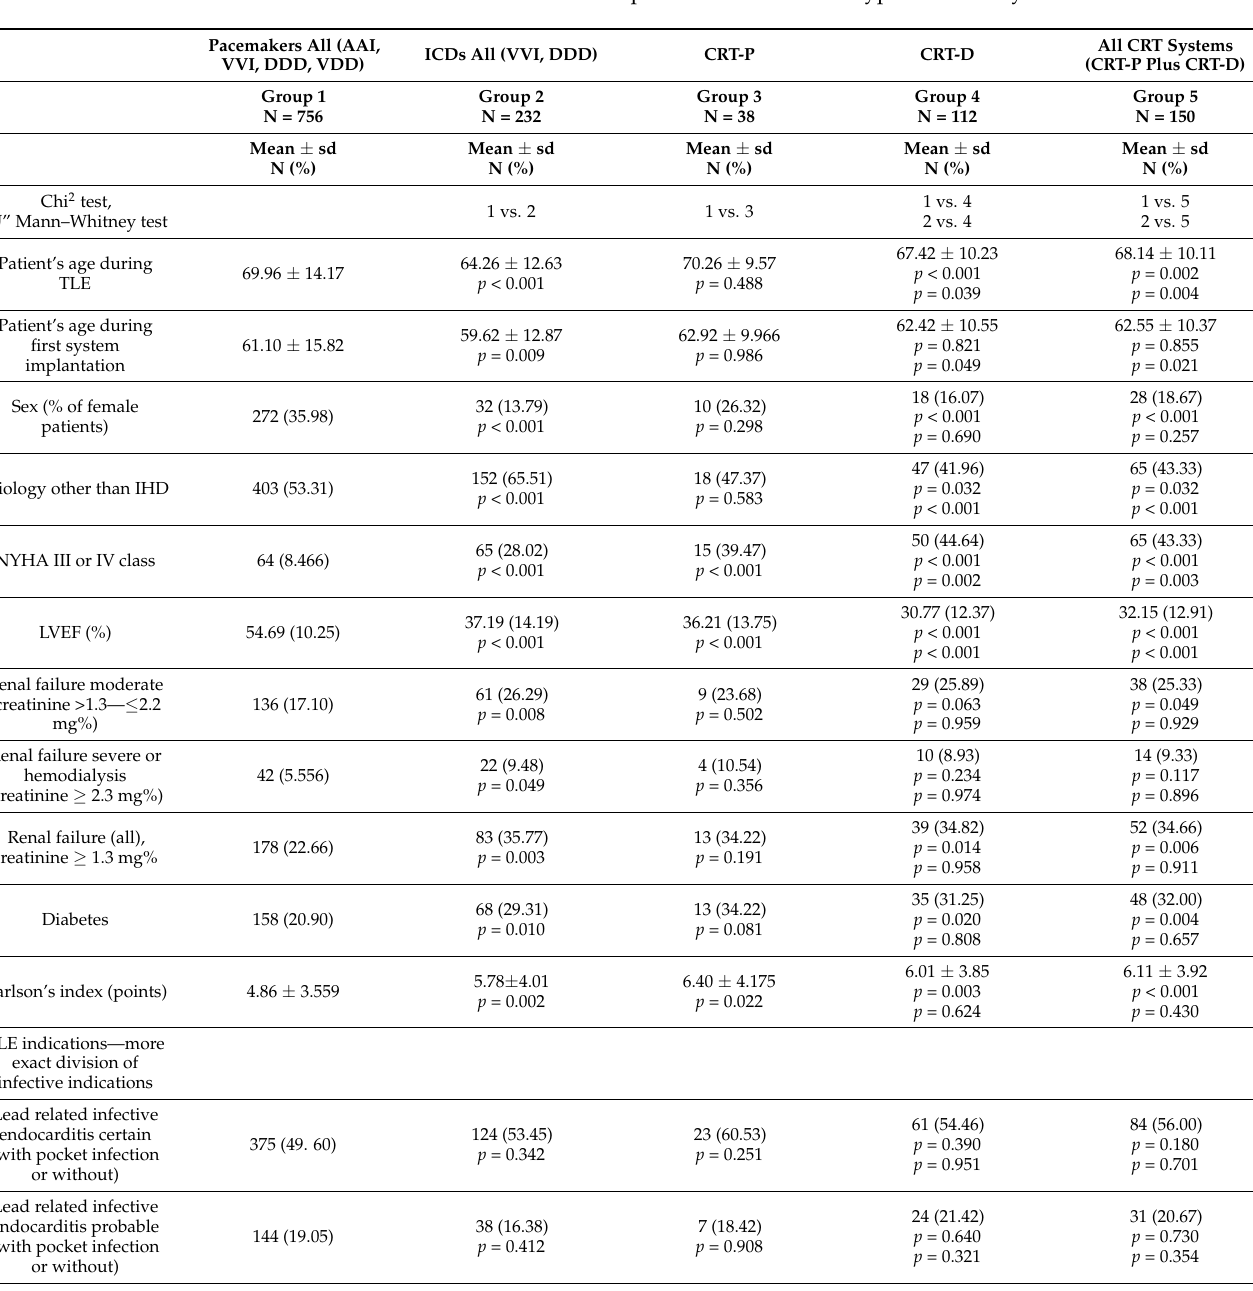
Table 2. Clinical characteristics of patients with different types of CIED